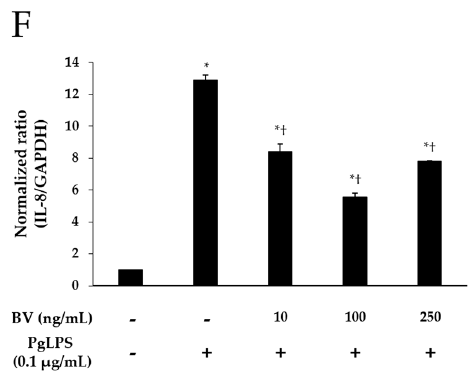
Figure 2. Effect of BV on the expression of pro-inflammatory mediators and TLR-4 in PgLPS-treated HaCaT cells. ELISA results demonstrate that BV suppressed the secretion of IL-1 β ( A ); and IL-6 ( B ); ( C ) Western blot analysis showed that BV inhibited the expression of IFN- γ , IL-8, TNF- α , and TLR-4. GAPDH was used to confirm equal sample loading. Results are representative of three independent experiments; ( D ) 10 and 100 ng/mL of BV suppressed TNF- α mRNA expression, and 250 ng/mL of BV encouraged TNF- α mRNA expression; ( E ) IL-6 mRNA expression was inhibited by 10, 100, and 250 ng/mL BV; ( F ) 10, 100, and 250 ng/mL of BV reduced IL-8 mRNA expression. Results are expressed